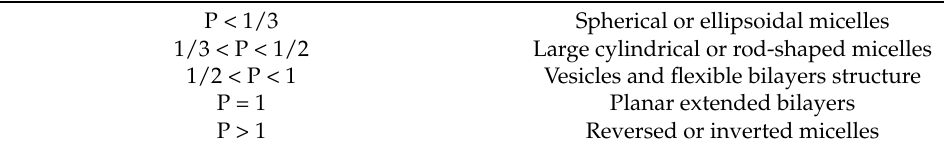
Table 3. Geometrical relations for spherical, cylindrical, and bilayer aggregates. P < 1/3 Spherical or ellipsoidal micelles 1/3 < P < 1/2 Large cylindrical or rod-shaped micelles 1/2 < P < 1 Vesicles and flexible bilayers structure P = 1 Planar extended bilayers P > 1 Reversed or inverted micelles